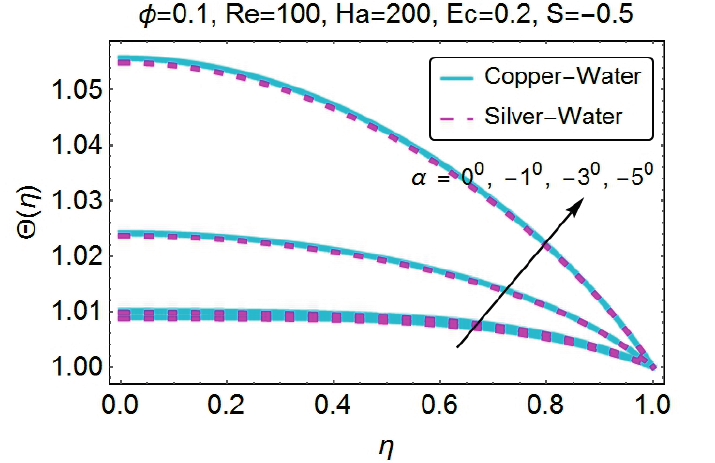
Figure 15. Change in temperature for varying α (convergent channel/shrinking